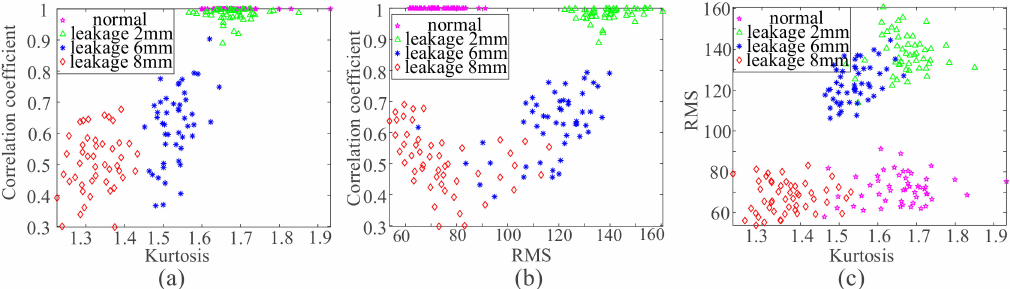
Figure 12. SVM classification e ff ect based on excitation CIs; ( a – c ) are the classification e ff ect of K and CC, RMS and CC as well as K and RMS as characteristic indicators,